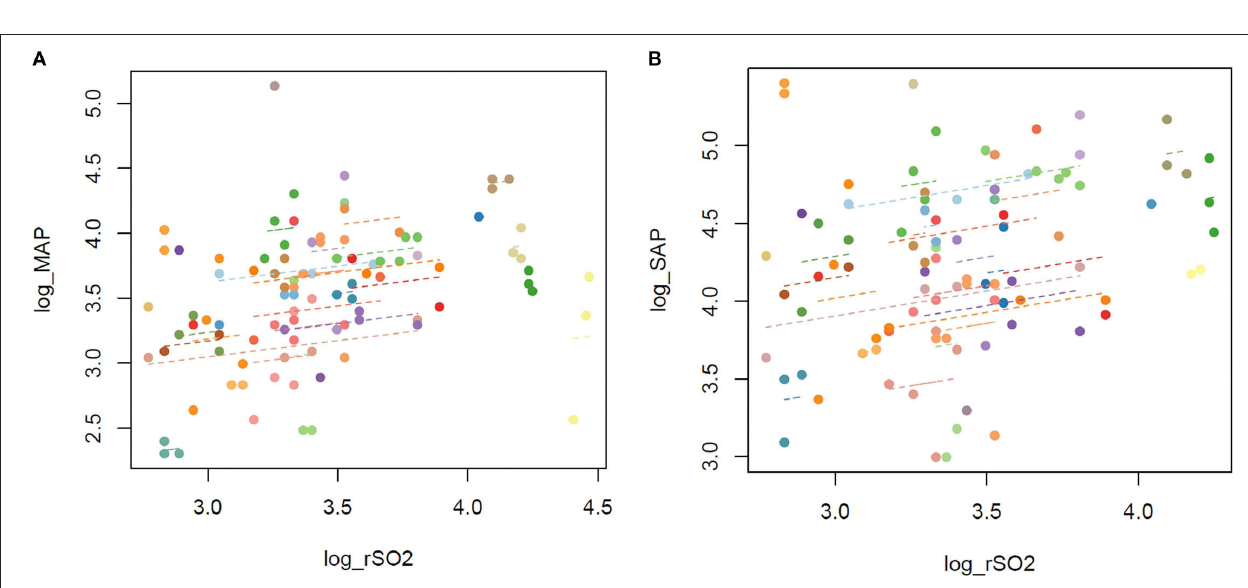
FIGURE 3 | (A) Scatterplot of MAP and rSO 2 in repeated measurements. (B) Scatterplot of SAP and rSO 2 in repeated measurements. MAP, mean arterial pressure; rSO 2 , regional oxygen saturation; SAP, systolic arterial pressure. The repeated measurements of MAP and rSO 2 from 0 to 15min are plotted.